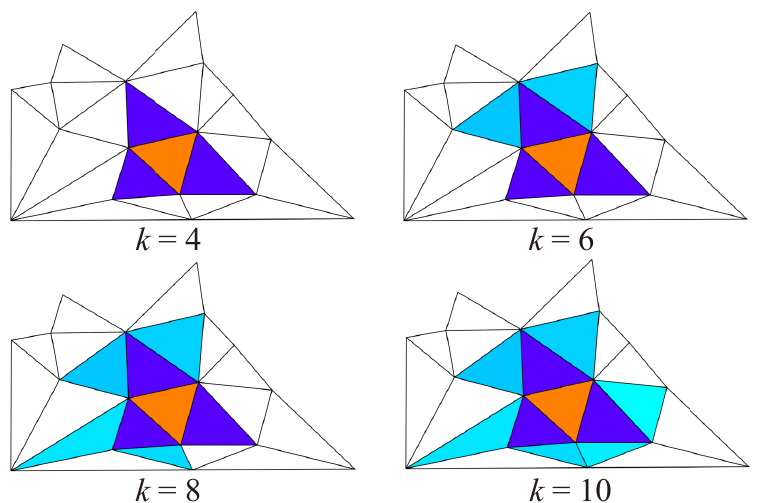
Figure 4. Visualization of the convolution receptive fields of different kernel size k . The orange parts are the center faces, which, together with the blue faces, constitute the convolutional receptive fields of the center faces.